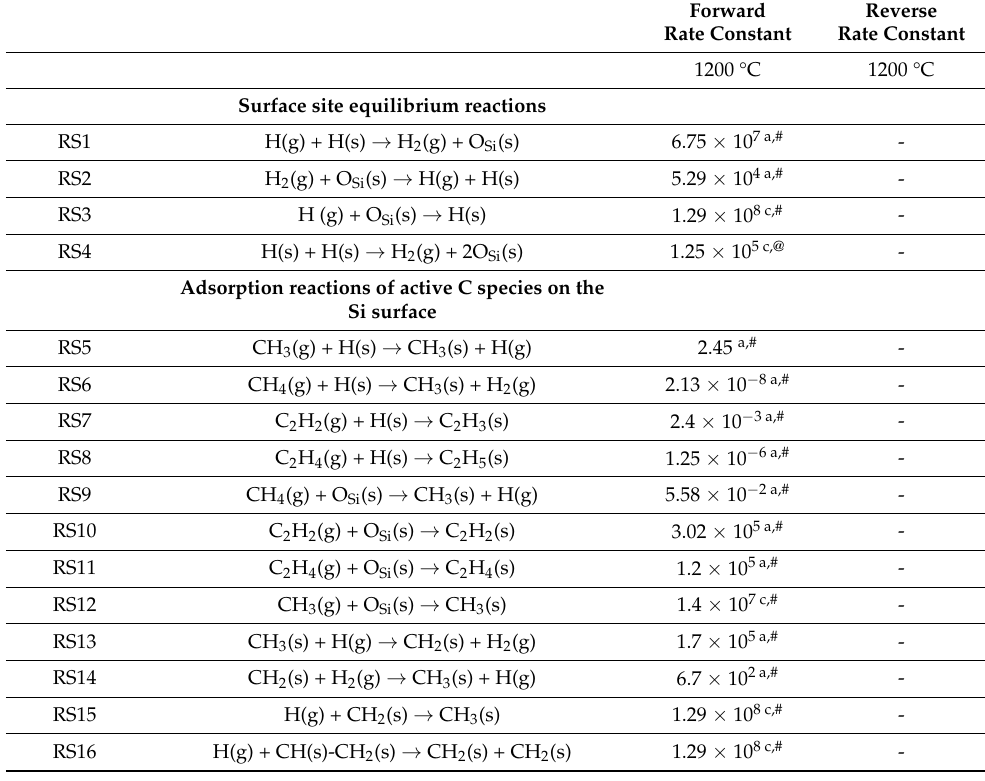
Table 1. Kinetic mechanism of surface reaction for